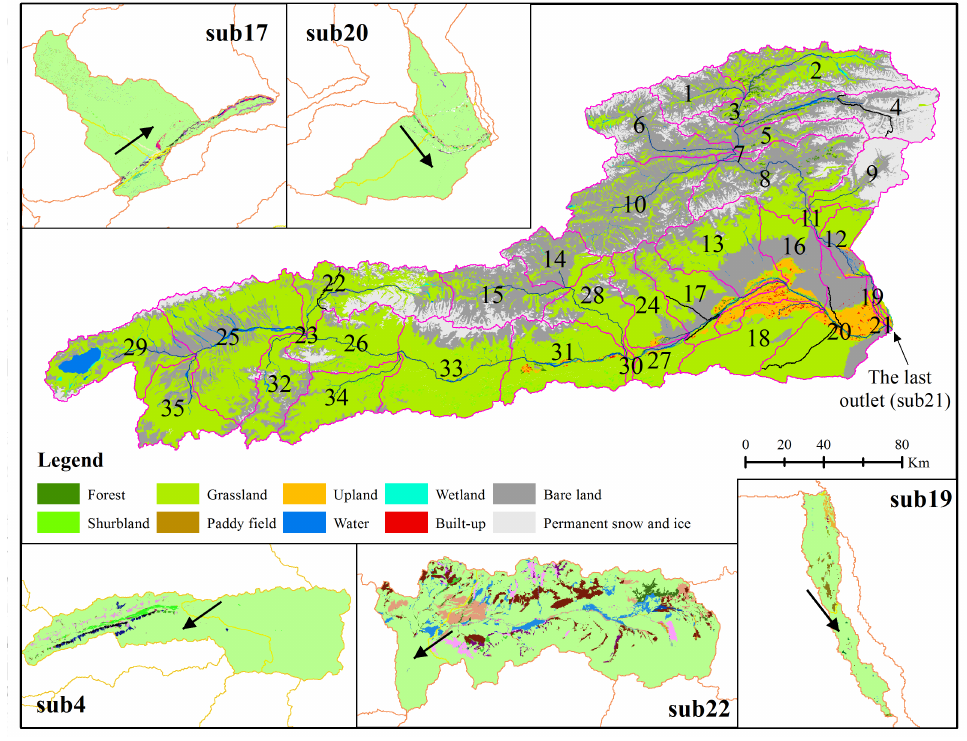
Figure 5. Typical sub-basin segmentation results based on land use/cover change in sub-basins (SUB) 4, 17, 19, 20, and 22 (the black arrow points to the direction of the